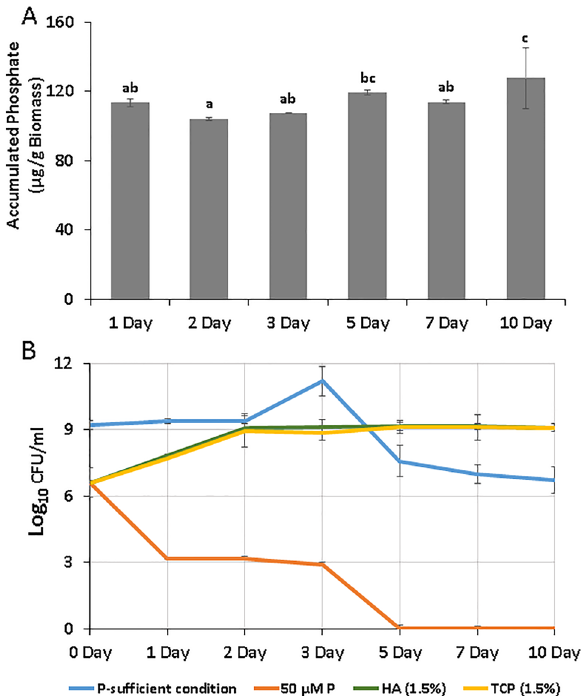
Figure 1. Accumulated phosphate within Pseudomonas putida biomass ( A ); Effect of different phosphate sources [(Normal P (0.3% KH 2 PO 4 + 1.2%Na 2 HPO 4 ), limited P (50 µM KH 2 PO 4 ) and unavailable P (1.5% hydroxyapatite and tricalcium phosphate] on growth of Pseudomonas putida ( B